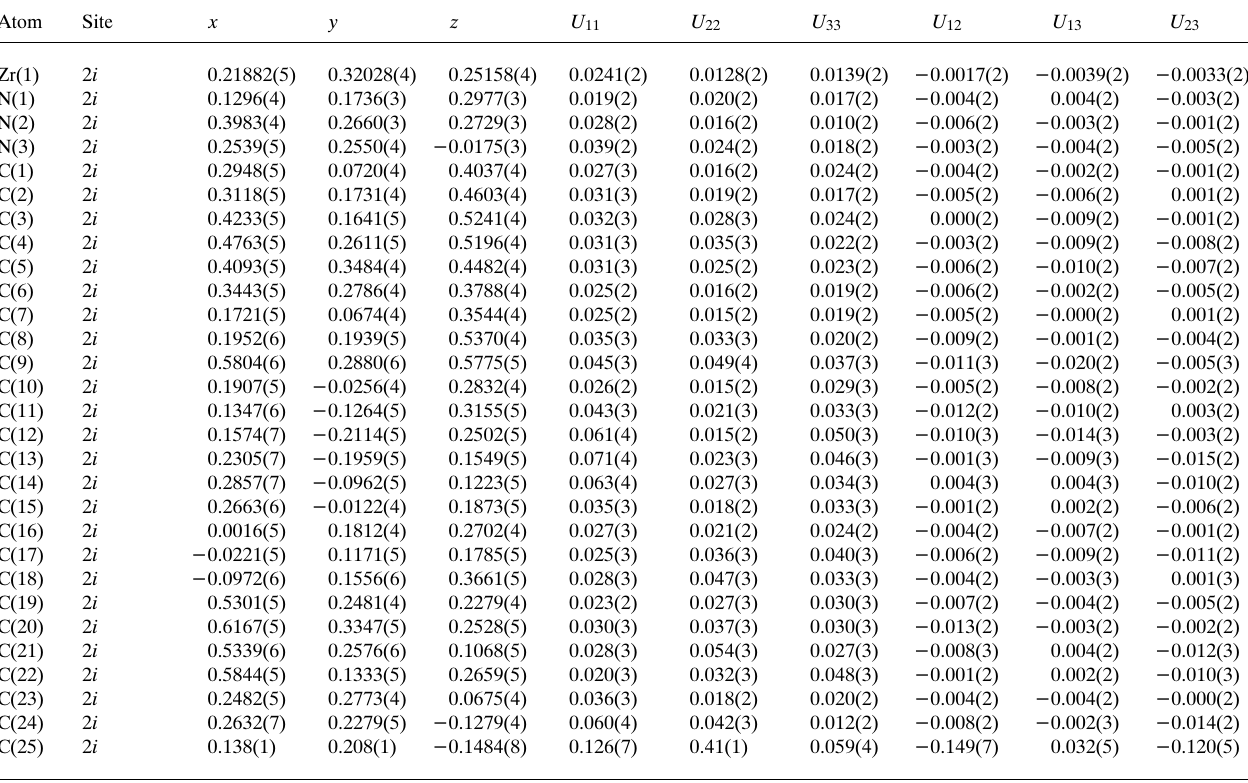
Table 3. Atomic coordinates and displacement parameters (in Å 2 ) .